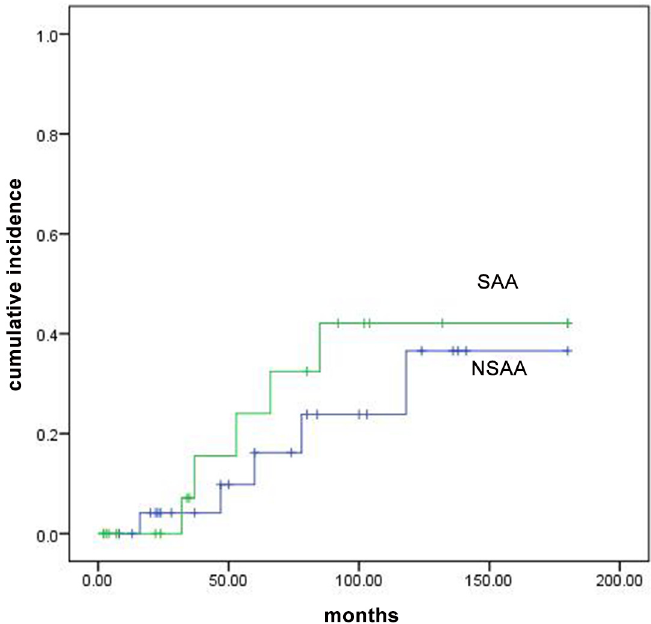
Fig 4. Cumulative incidence of relapse for patients with SAA and